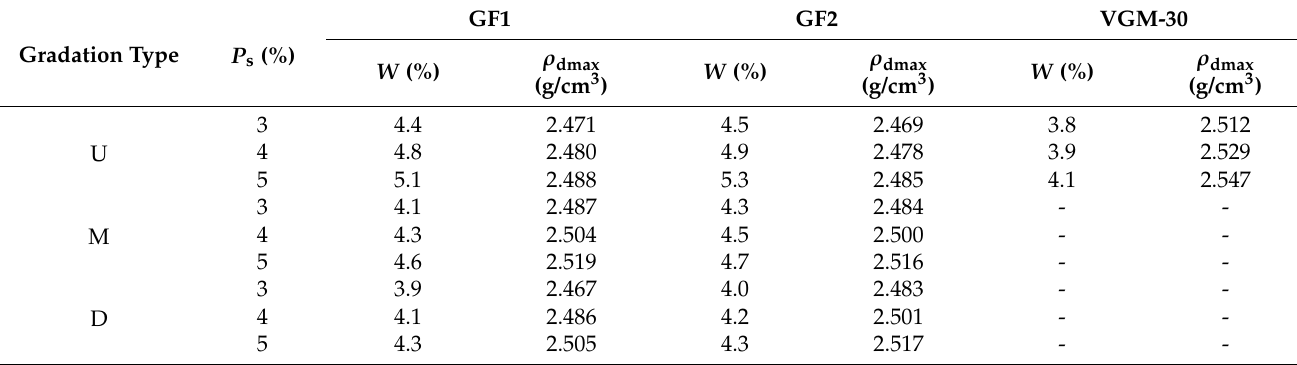
Table 4. Optimal moisture content and maximum dry density.